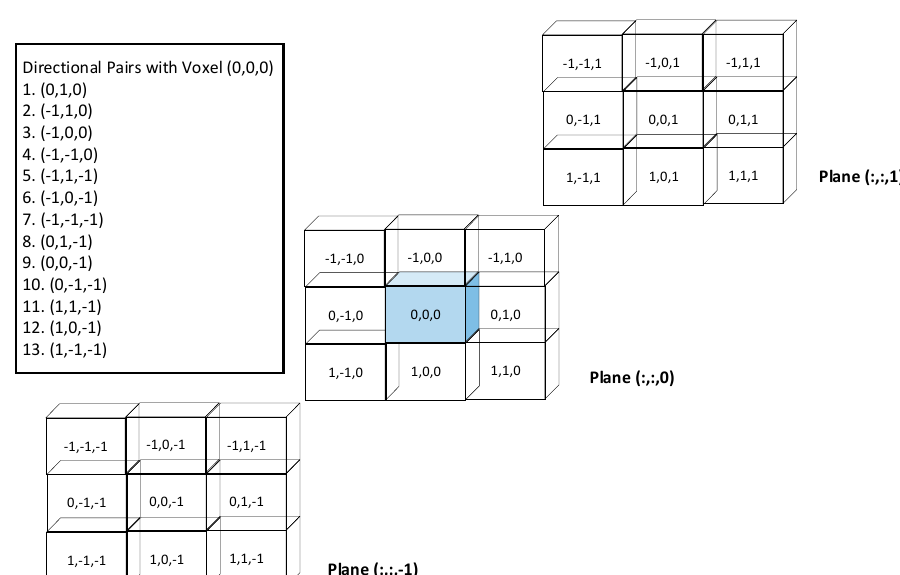
Figure 13. Neighborhood and directional voxel pairs in relation to GLCM analysis, adapted from Jardine et al. [24]. All three planes are in a 26-connected neighborhood of voxels, in which there exist 13 unique directional pairs with the origin voxel (0, 0, 0). Keep in mind that mirrored direction does not count as a unique direction, e.g., direction (0, 1, 0) has the same direction with (0, − 1, 0), direction (0, 0, − 1) has the same as (0, 0, 1), and so on.